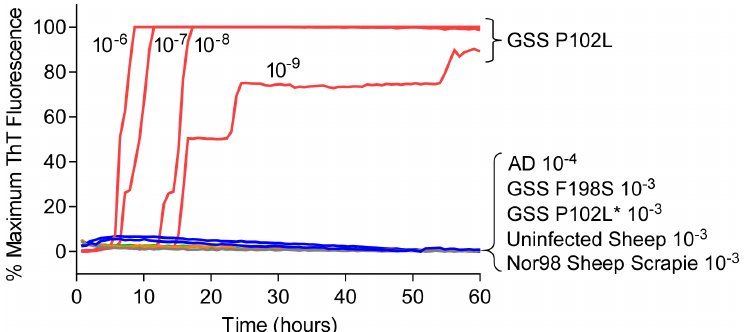
Fig 1. RT-QuIC detection of GSS P102L and lack of detection for GSS F198S, P102L * and sheep atypical Nor98 scrapie using hamster rPrP Sen 90 – 231. Serial dilutions (10 -6 to 10 -9 ) of GSS P102L brain tissue dilutions were used to seed quadruplicate RT-QuIC reactions (red lines) with hamster 90 – 231 rPrP Sen as the substrate, 300mM NaCl, 0.002% SDS. The same rPrP Sen and RT-QuIC conditions listed above were used in reactions seeded with the designated brain tissue dilutions of GSS human patients with F198S (green line) or P102L * (gray line) PRNP point mutations, Alzheimer ’ s disease (AD, blue line), sheep without prion disease (blue line) or with Nor98 scrapie (orange line). Average ThT fluorescence readings from replicate wells for each type of sample were plotted as a function of time. Results are representative of similar findings from at least 10 independent experiments using hamster 90 – 231, hamster 23 – 231, human or hamster-sheep chimeric rPrP Sen